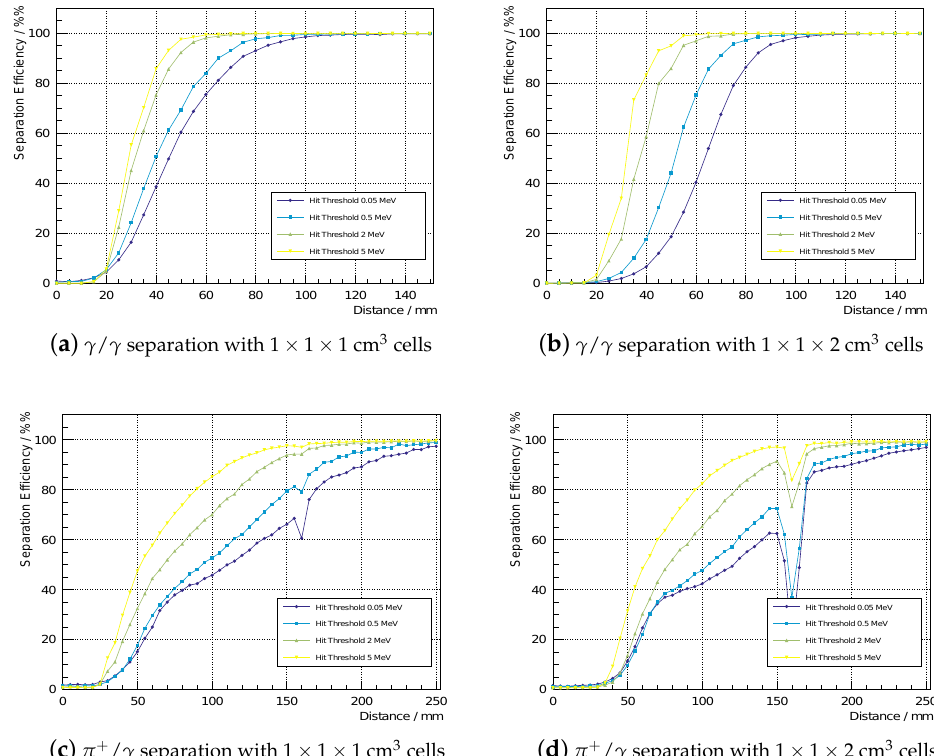
Figure 3. Separation efficiency with varying distances between two incident particles using two sets of crystal